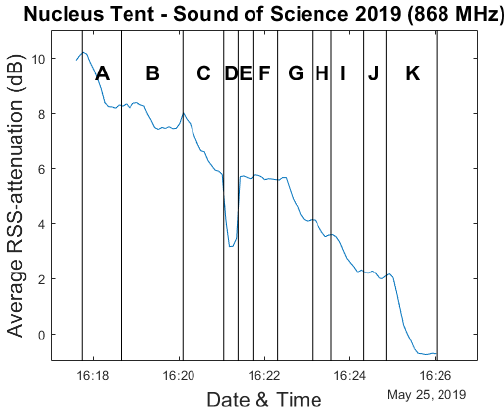
Figure 15. Evolution of the average RSS attenuation during the experiments in the Nucleus tent